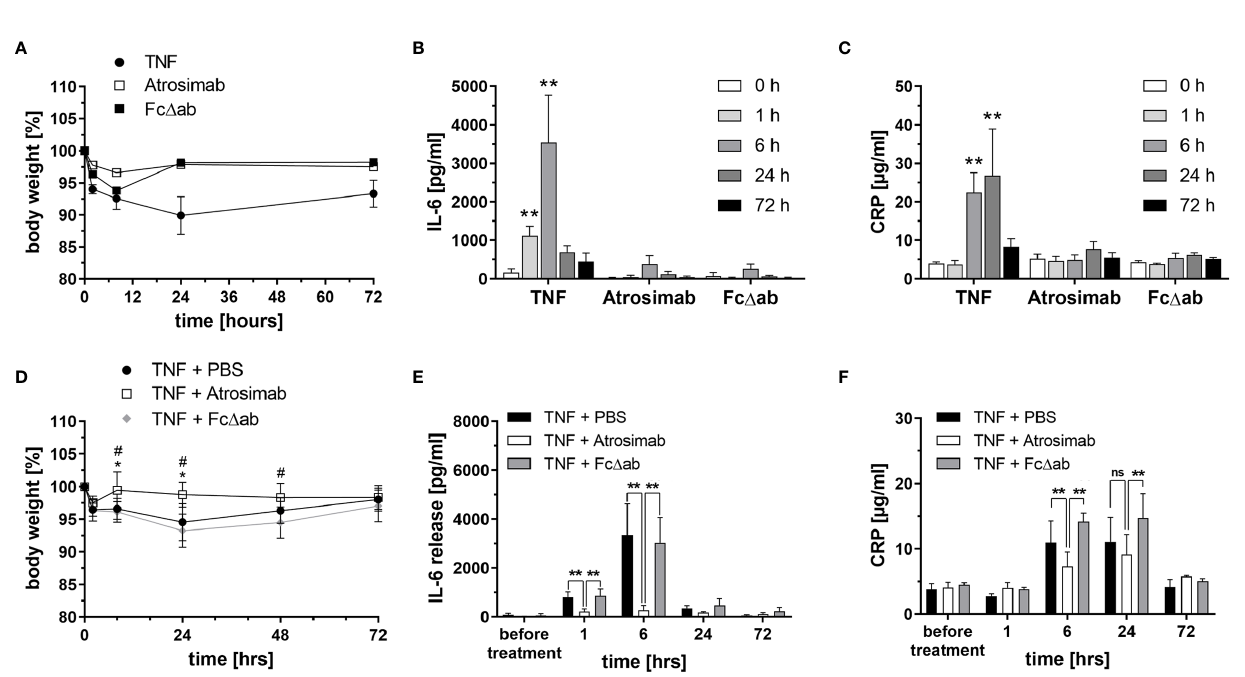
FIGURE 3 | Atrosimab blocks acute TNF-induced in fl ammation in vivo. (A – C) C57BL/6 huTNFR1-k/i mice received i.v. injections of TNF (0.3 mg/kg), Atrosimab or Fc D ab (30 mg/kg). (A) Body weight was determined and (B, C) blood samples were collected before treatment (0 h) and 1 h, 6 h, 24 h and 72 h after the injections. (B) IL-6 and (C) CRP levels in the serum were determined by ELISA. (D – F) C57BL/6 huTNFR1-k/i mice received i.v. injections of PBS, Atrosimab (30 mg/kg body weight) or Fc D ab (30 mg/kg). TNF (0.3 mg/kg) was injected 30 minutes thereafter to induce acute in fl ammatory responses. (D) Body weight was determined and (E, F) blood samples were collected before treatment (0 h) and 1 h, 6 h, 24 h and 72 h after TNF injection. (E) IL-6 and (F) CRP levels in the serum were determined by ELISA. Individual values were excluded using the ROUT method of outlier identi fi cation (Q = 1%) or because they were below the detection limit of the ELISA. Mean ± SD, n=6. (A, C) : **p < 0.01; (D) : *p < 0.05 – TNF + PBS vs TNF + Atrosimab, # p < 0.05 – TNF + PBS vs TNF + Fc D ab; (E, F) : ns, not signi fi cant, **p < 0.01.